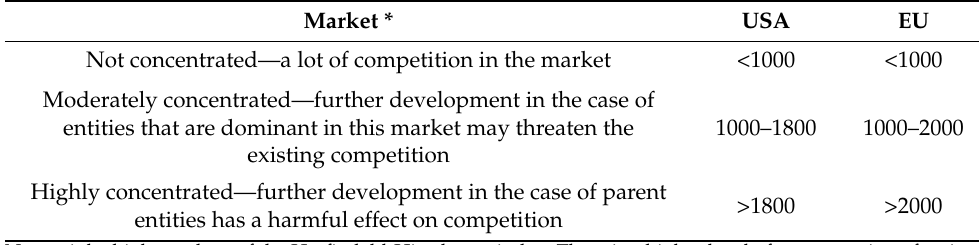
Table 1. Herfindahl-Hirschman index and levels of market